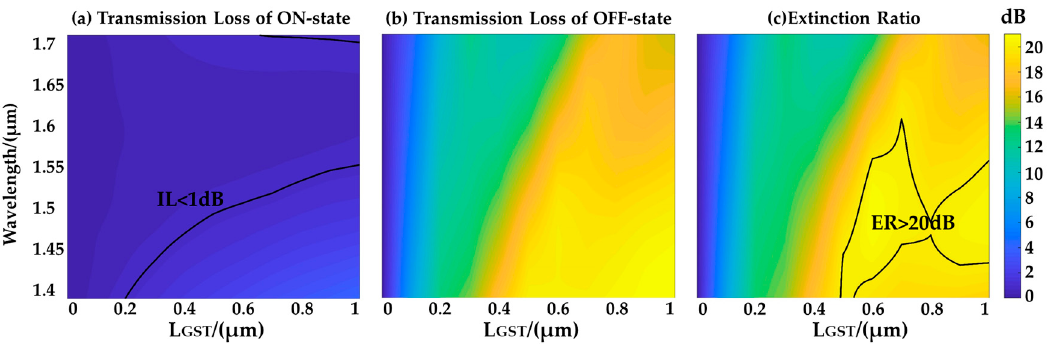
Figure 5. ( a ) Transmission loss of ON-state (amorphous phase). ( b ) Transmission loss of OFF-state (crystalline phase). ( c ) ON-OFF switching extinction ratio after phase change of